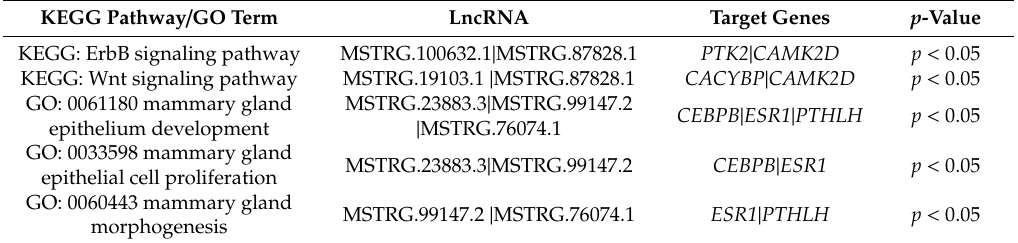
Table 1. Functional annotation of the target genes of differentially expressed lncRNAs between Gansu Alpine Merino (GAM) and Small-Tailed Han (STH) ewes. KEGG, Kyoto Encyclopedia of Genes and Genomes; GO, Gene Ontogeny.